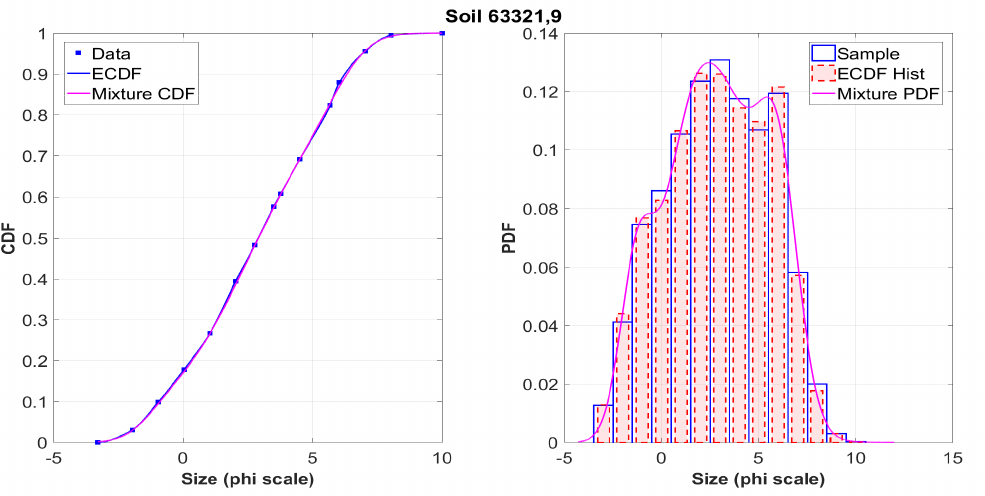
Figure A7. Soil 63321,9 (“Apollo 16”).